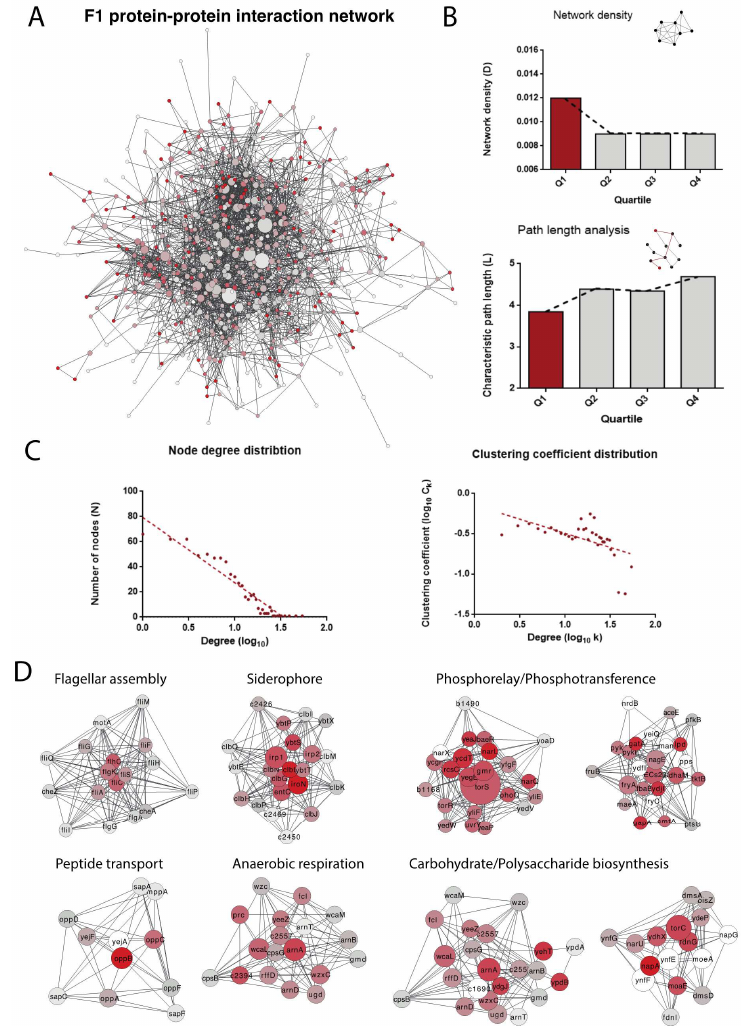
Figure 3. Protein-protein interconnectivity of fitness-related genes. ( A ) Representation of the protein-protein interaction network of genes belonging to the F1 group, based on data deposited in the String database. Only experimentally validated interactions were used. The size of the nodes in the network indicates betweenness centrality, i.e., the number of shortest paths that pass through the node. Node size is proportional to betweenness centrality, colour from grey to red indicates an increasing clustering coefficient and line width is proportional to edge centrality. ( B ) Analysis of the network density and pathway length for the F1, F2 and F3 networks. ( C ) Node degree and clustering coefficient distribution of the F1 interaction network. The plots show that the F1 network follows a typical free-scale distribution with a moderate degree of modularity. ( D ) Protein clusters detected for the F1 network using the Cluster One algorithm. Only clusters with p -values < 0.05 were selected ( p -values were calculated using the Mann-Whitney U test performed on the in- and out-weights of the